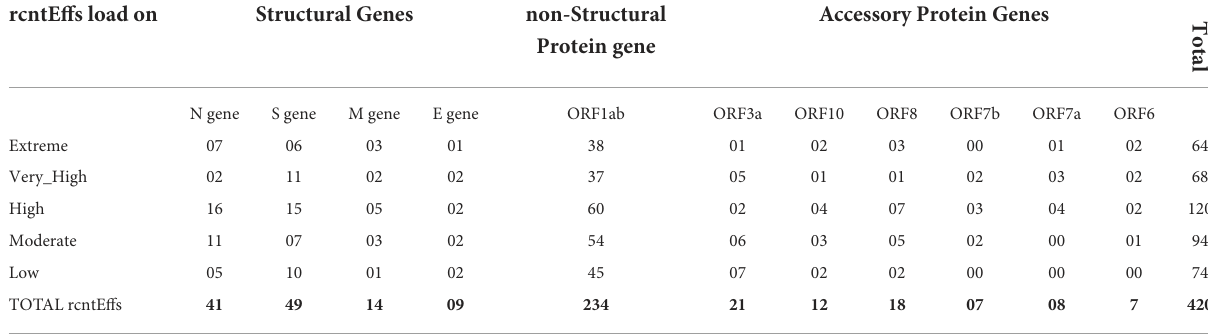
TABLE 2 Functional effects of all identified category-specific recurrent SNVs (CaSp-rcntEffs) counts identified in all 2,500 SARS-CoV-2 genomes and their respective per WHO’s defined UVindex category distribution. rcntEffs load on